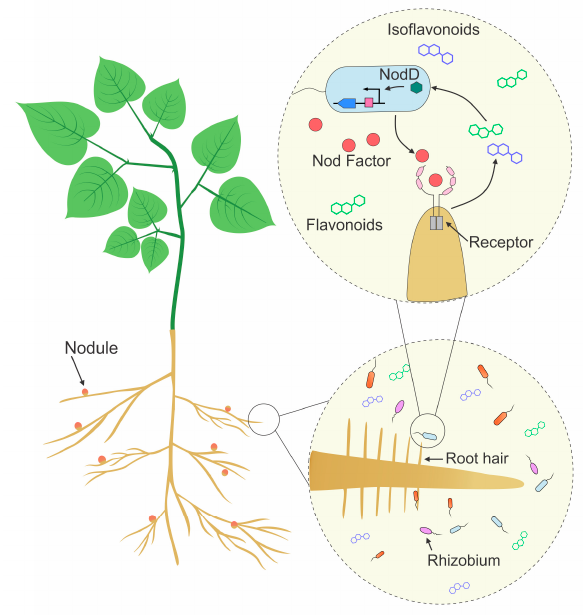
Figure 1. Signal exchange in the legume-rhizobia interaction. Flavonoids and isoflavonoids secreted by legume roots activate the Nodulation protein D (NodD) transcription factor on compatible rhizobia inducing the transcription of nod genes, which are required for the synthesis of Nod factors. Nod factors are perceived by receptors present in the plasma membrane of root cells, triggering the signaling pathway required for the development and infection of the nodule, where bacteria are allocated, and nitrogen fixation occurs.